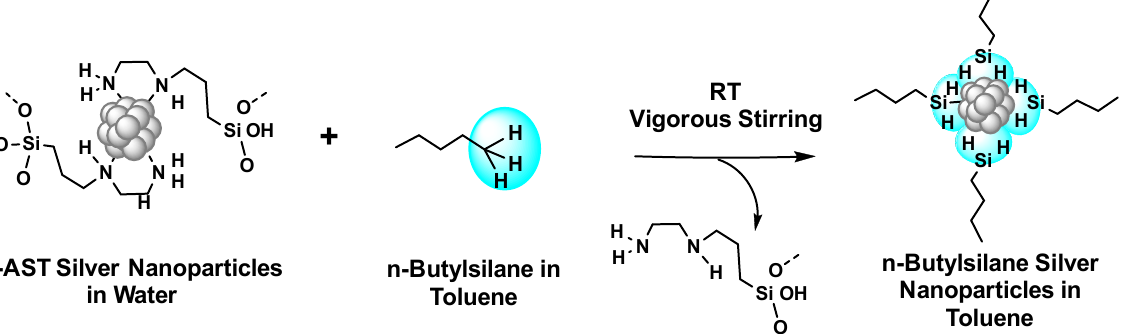
Scheme 3. A schematic representation of the phase transfer of 2-AST stabilized silver nanoparticles using short- and long-chain alkylsilanes. Scheme adapted from Chauhan et al. [12].